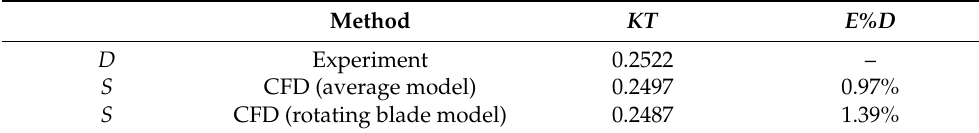
Table 9. KT result for behind hull